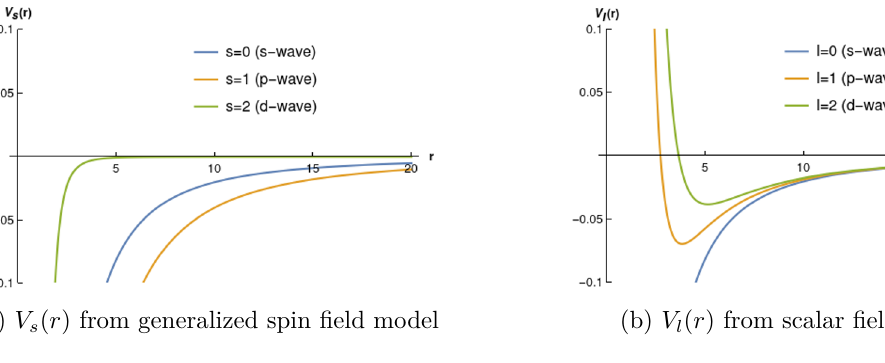
Figure 7. Plot of V s ( r ) and V l ( r ) for m 2 = − 2 with Schwarzschild-AdS 4 metric with r h = 1 in different wave states s, p, d . Left figure is for spin field model with different spin value and the figure in right hand side is for Abelian-Higgs model with α = α l 1 = 0 , 3 . 8317 , 5 . 1356 (setting a = 1 ) for a different angular momentum value l = 0 , 1 , 2 respectively. Here l = 1 and l = 2 represent the excited states in the scalar field